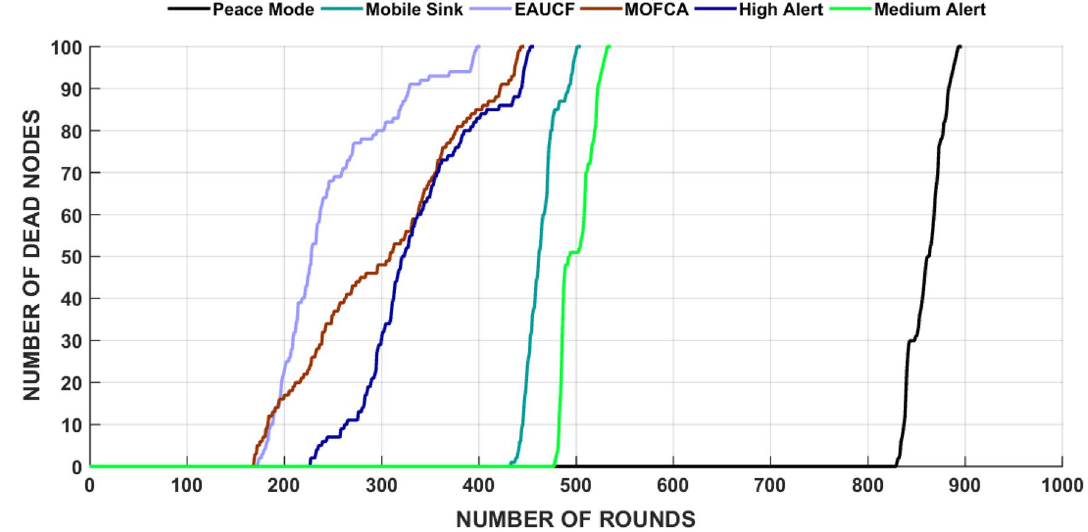
Fig. 5 The ratio of the number of dead nodes to the number of rounds in scenario